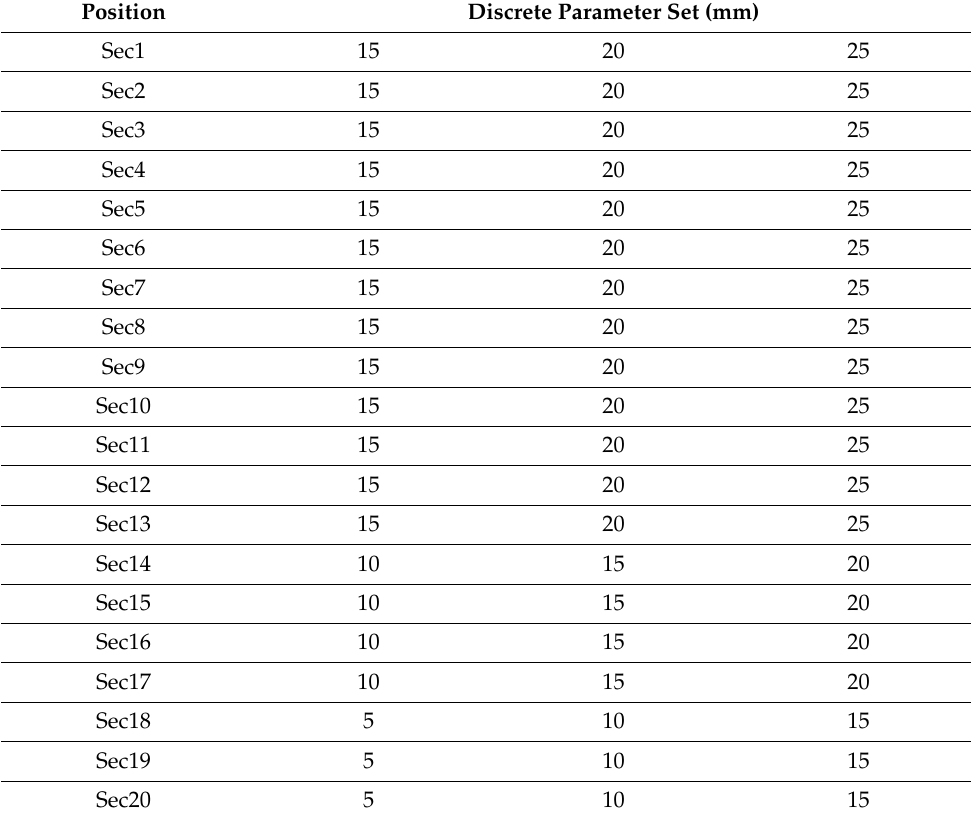
Table 1. Discrete input parameters in parameter set.